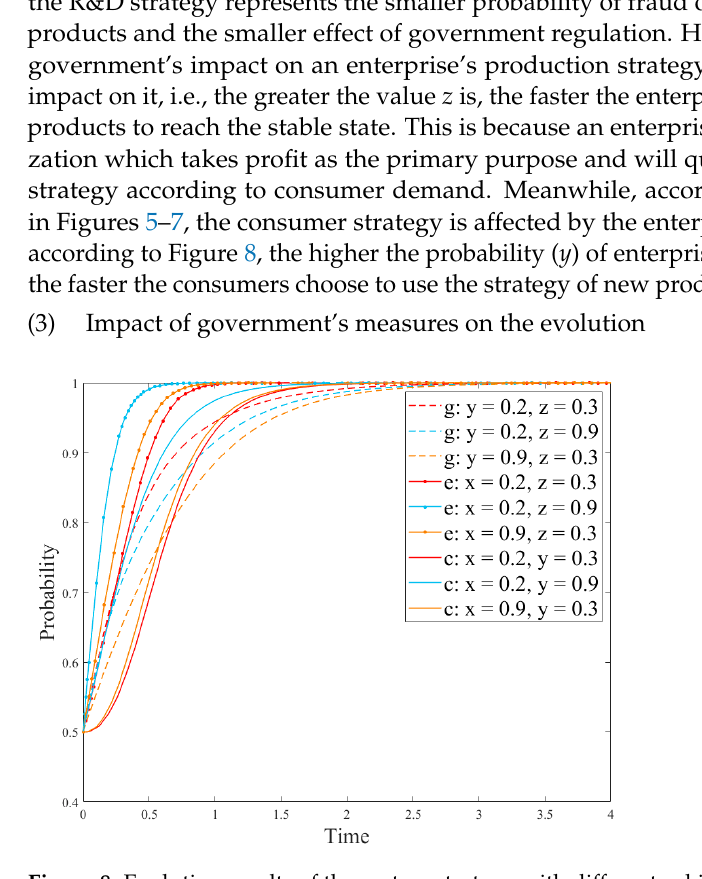
Figure 8. Evolution results of the system strategy with different subject’s initial strategy (g: government, e: enterprise, c: consumer).